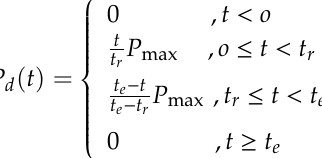
Figure 8. Explicit solution model II (top dynamic loading). 4. Numerical Results Analysis 4.1. Energy Evolution around a Large Deep Stope Notably, deep unexcavated rock masses can store energy. When the dynamic load propagates in a rock mass with a free surface, the rock mass experiences repeated loading and unloading [38]. If the stress exceeds the strength of the rock mass, the deep opening undergoes instantaneous collapse or stripping. Indicators of damage (e.g., stiffness, strength, strain energy density (SED), energy release rate, etc.) are used for risk assessment in deep engineering. To identify the transition and transformation of the energy in a rock mass and use the results and conclusions of laboratory tests to guide field engineering practice, the index of strain energy density is often used to study the rules of energy evolution in deep mines because it eliminates the influence of the size effect. As an energy analysis index without volume dependence, the strain energy density perfectly fits the quasi-3D model in this study [39] and can be written as: